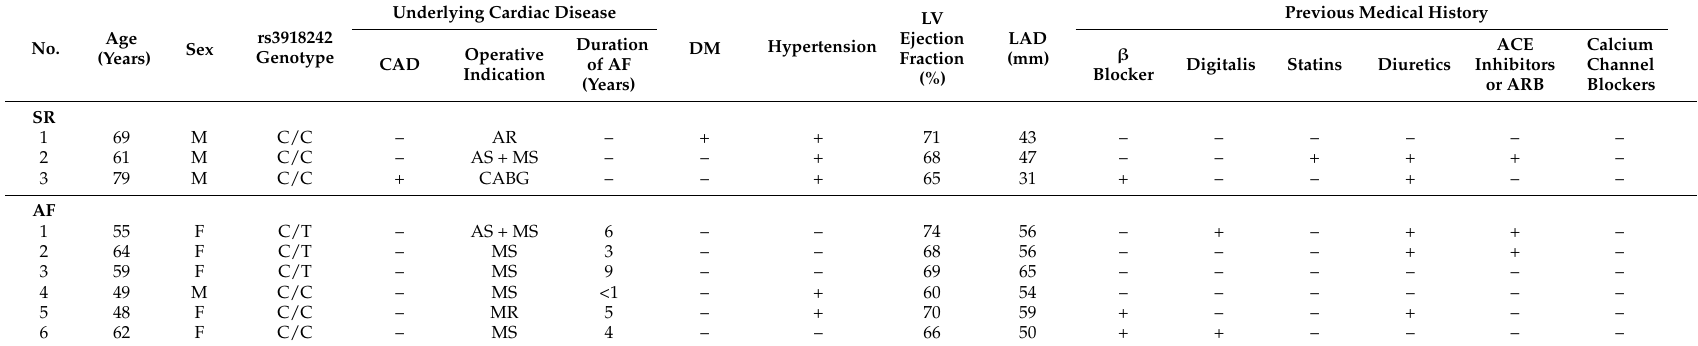
Table 3. Clinical characteristics of patients with normal sinus rhythm (SR) and atrial fibrillation AF at the time of cardiac